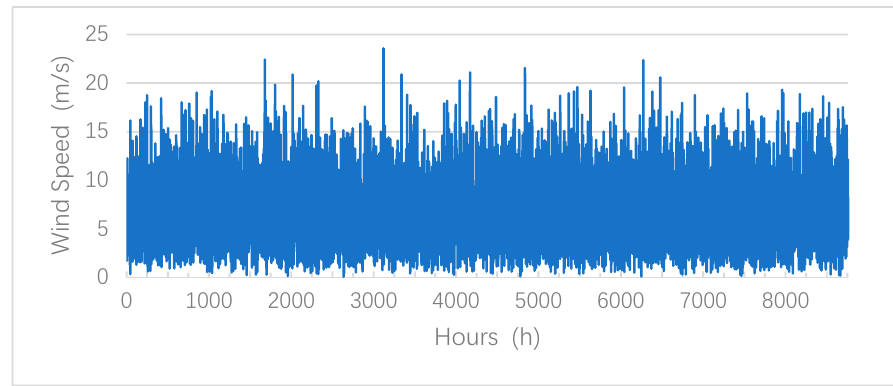
Figure 3. Annual wind speed of the studied site.